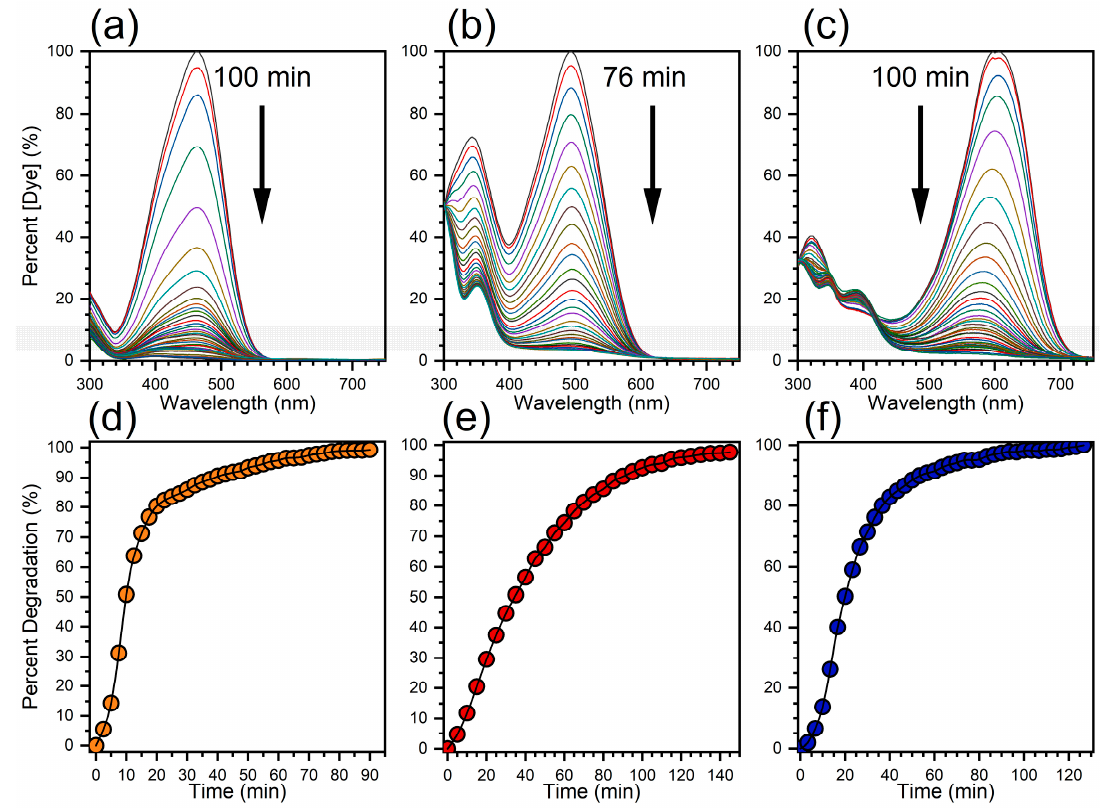
Figure 4. ( a – c ) UV/vis spectra for percentage dye concentration remaining, and ( d – f ) time plots of percent dye degradation for the catalytic reduction of MO, CR, and CSBB, respectively, by NaBH 4 in the presence of 200 mg Ag NP–cotton.